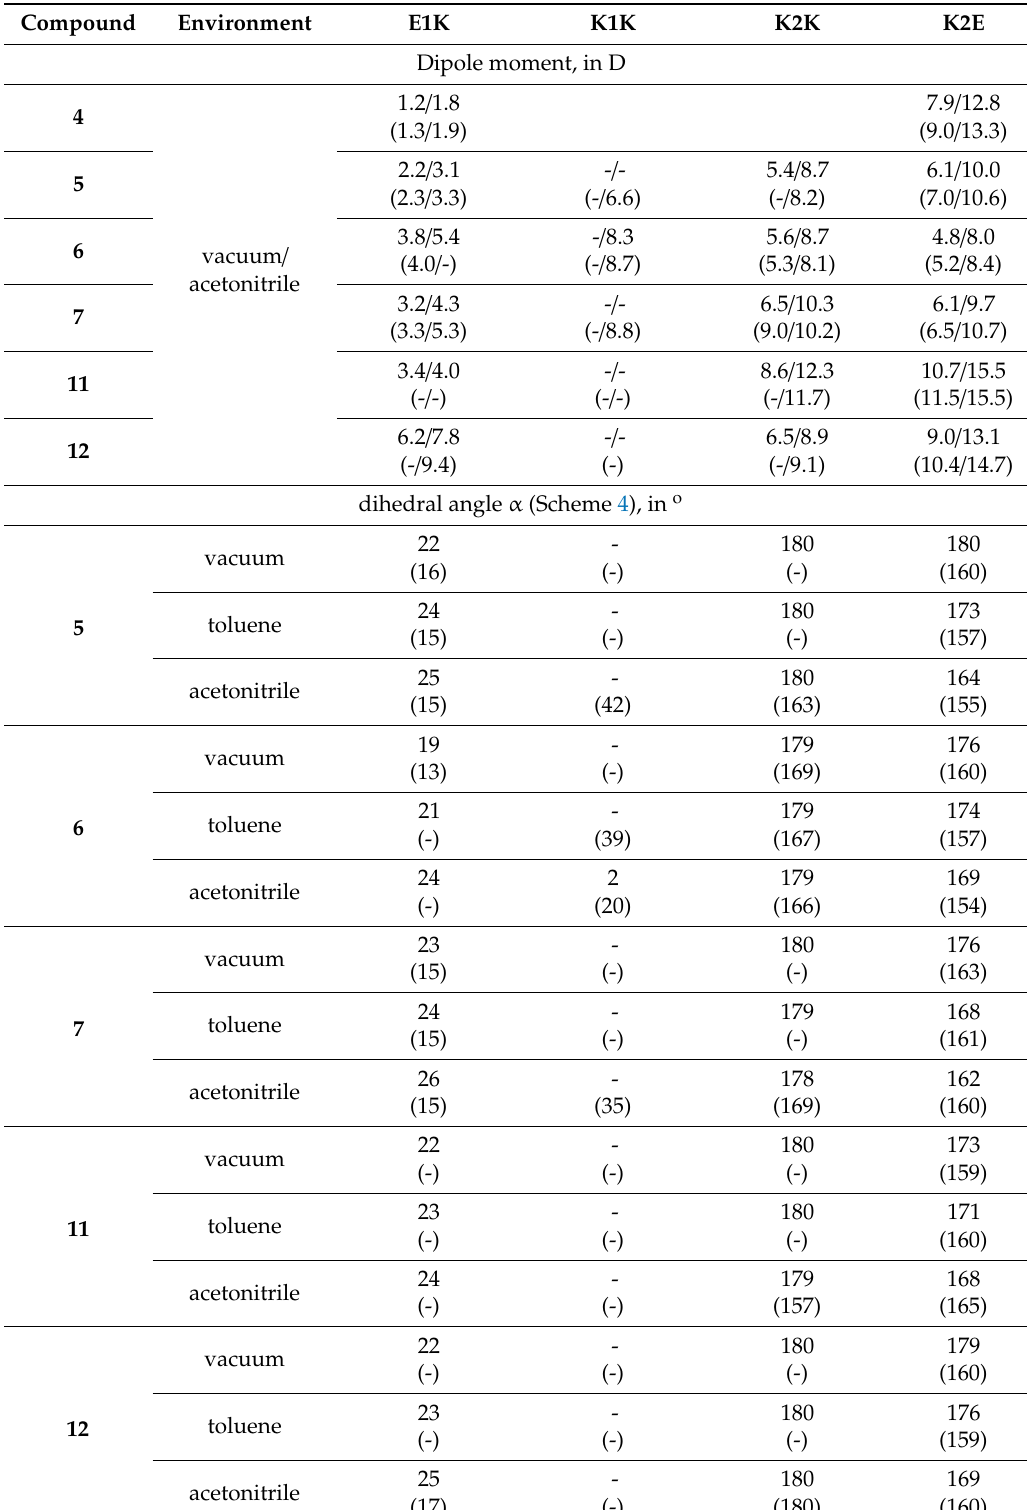
Table 2. Important structural parameters of the tautomers of 4 – 7 and 11 – 12 in ground and excited S 1 (in brackets)